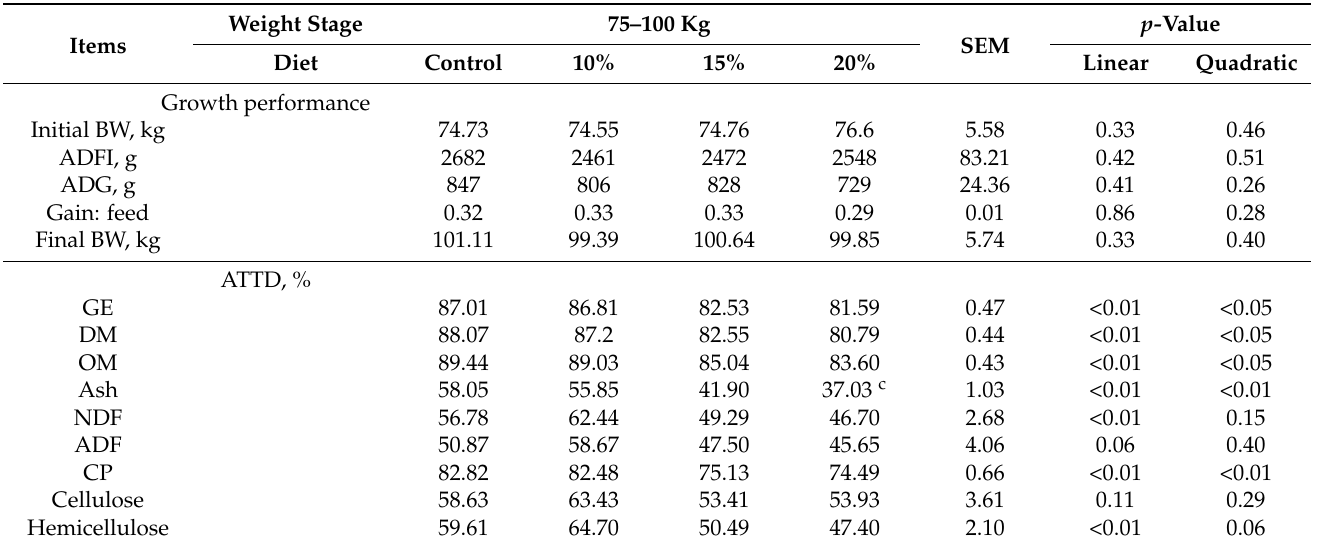
Table 5. Effects of inclusion level of defatted rice bran on growth performance and apparent total tract digestibility in weight stage 3 1